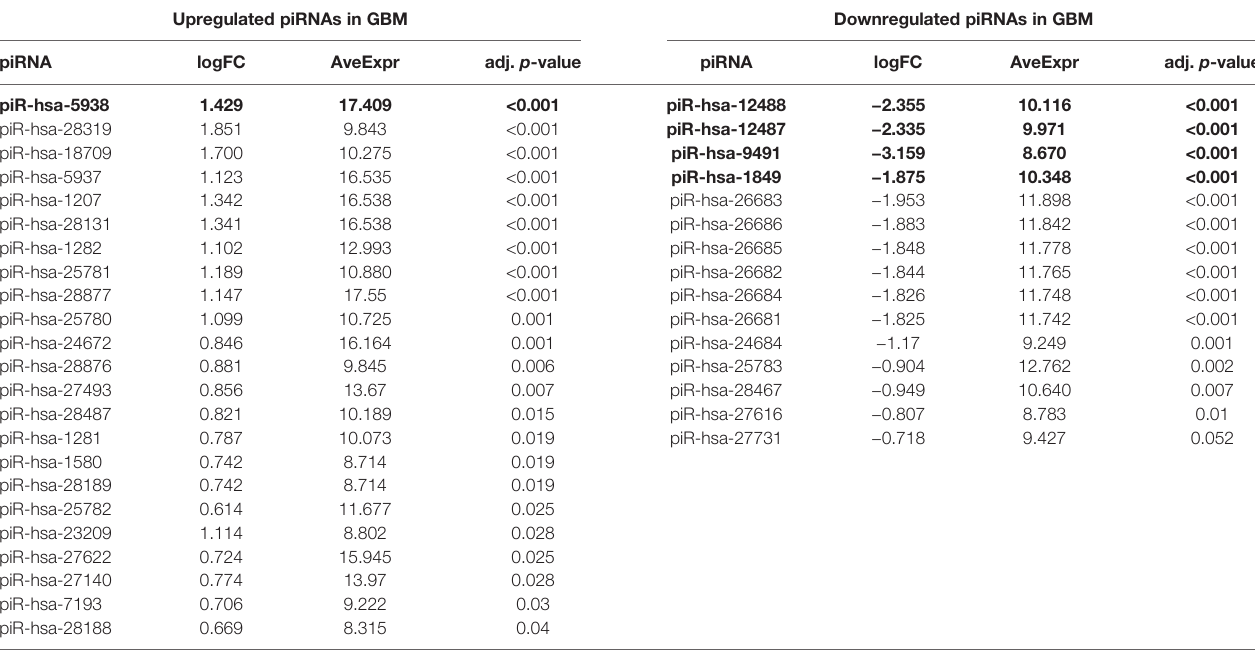
TABLE 2 | List of the signi fi cantly dysregulated PIWI-interacting RNAs in GBM patients compared to non-tumor controls based on next-generation sequencing data. Upregulated piRNAs in GBM